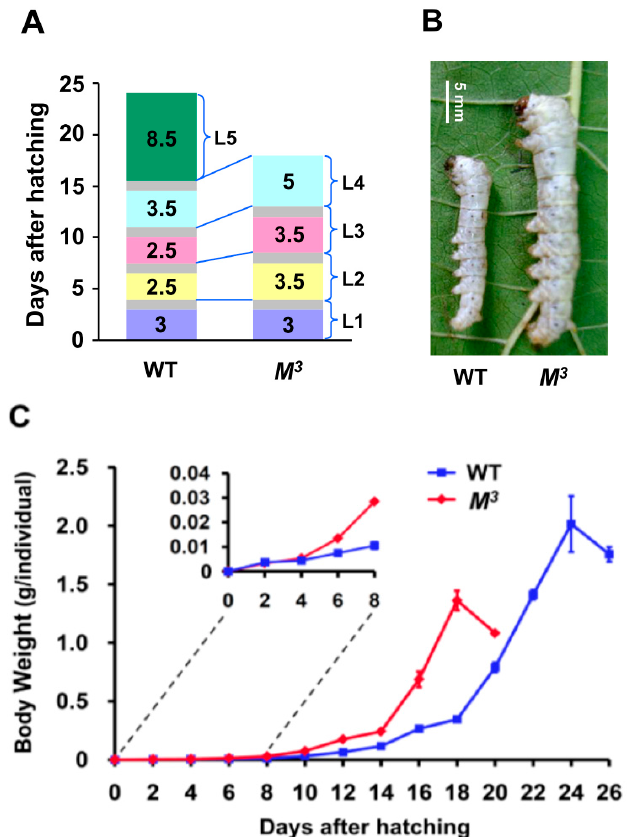
Figure 1. Developmental phenotypes of the M 3 mutant. ( A ) Precocious larval-pupal metamorphosis in the M 3 mutant. The M 3 larvae undergo only three molts. The feeding duration of the second and third instars is greater than that of the same instars in the WT larvae, and the entire larval period of the M 3 mutant is six days shorter than that of WT. The gray areas denote the process of larval molting. L, larval instar; L1 to L5 respectively represents the first to the fifth larval instar; ( B ) Morphology of the M 3 and WT larvae on the 11th day after hatching. The WT larvae have progressed into the third larval molting, but the M 3 larvae remain at day two of the third larval instar, and their body size is bigger than that of the WT larvae; ( C ) Comparison of the body weights of the M 3 and WT larvae. We randomly chose a certain number of both M 3 and WT individuals every 48 h from the first day they were hatched and got the average body weight. Beginning with the second instar, the body weight of the M 3 larvae increased faster than that of the WT larvae. Because of the lack of a larval instar, the final body weight of the M 3 larvae was less than that of the WT larvae. The error bars represent the mean ˘ S.E. ( n =